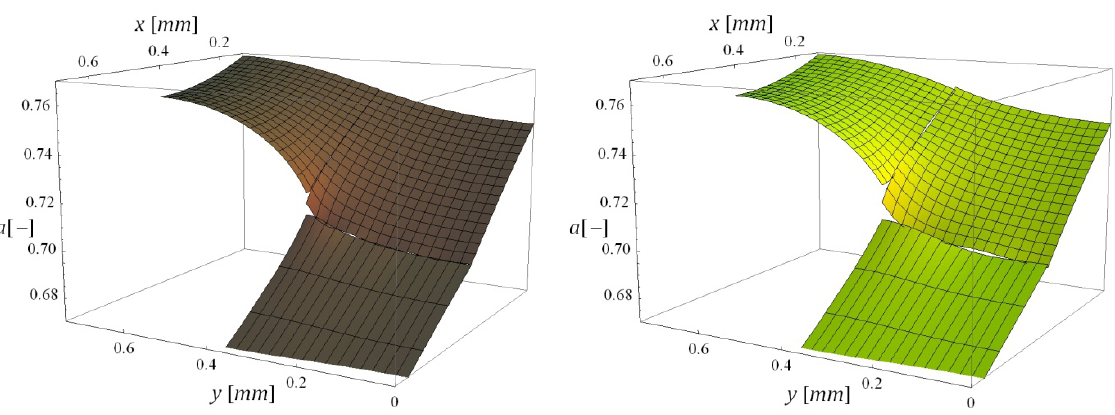
(brown) and HAN (yellow). Close-up of the 6 3